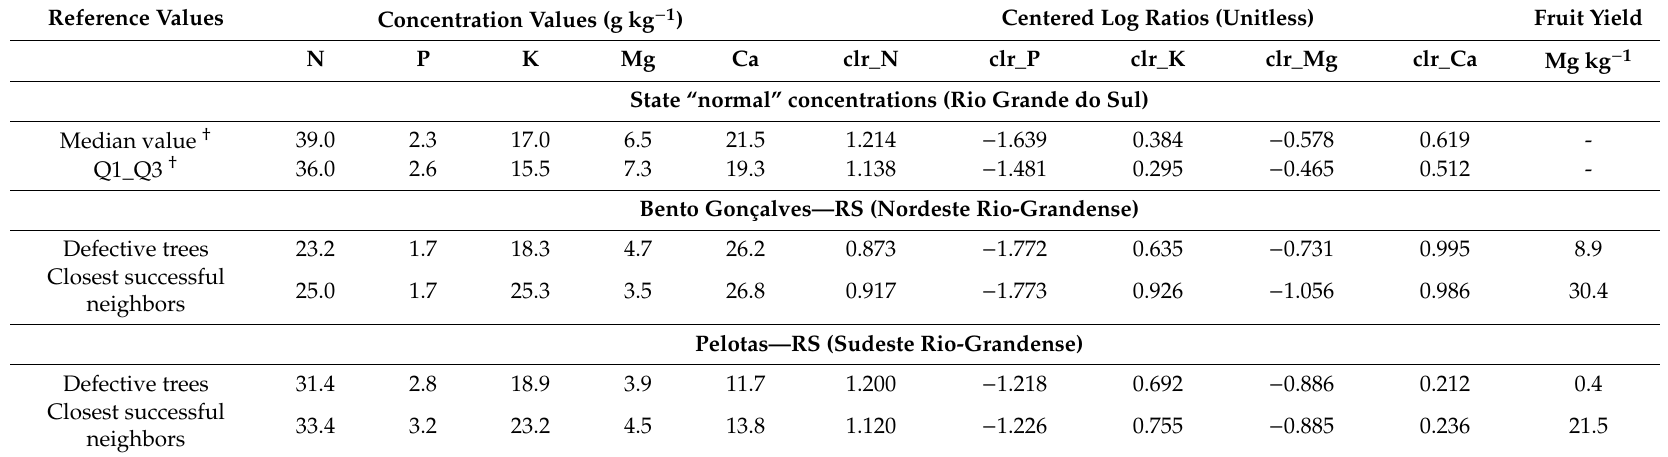
Table 8. Reference concentration and clr values for macronutrients from state standards and closest true negative specimens in two contrasting regions of Rio Grande do Sul (RS),